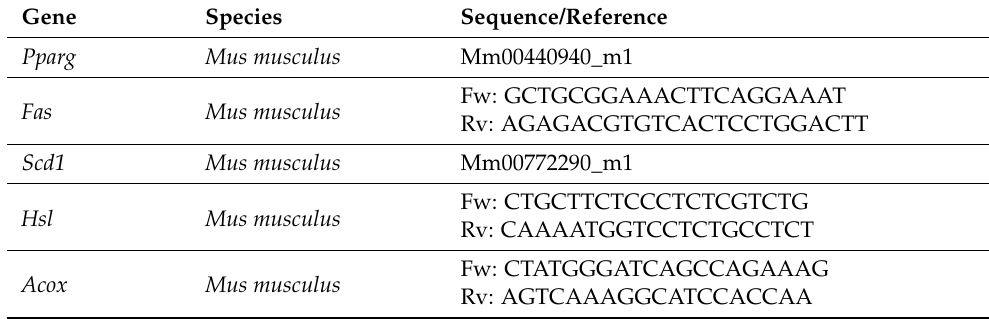
Table 2. Sequences of primers used in this